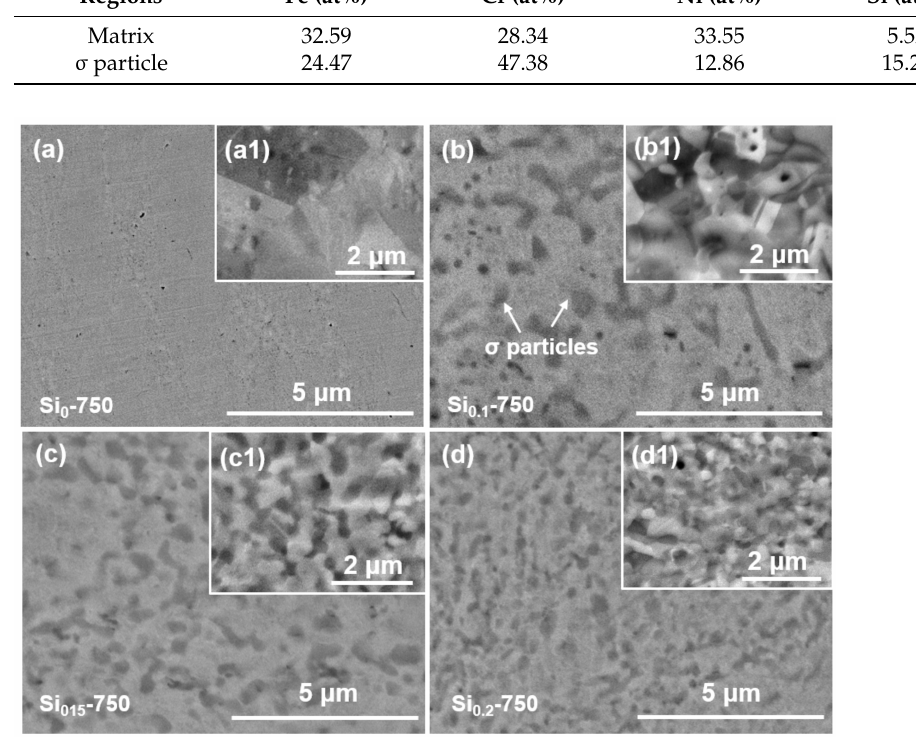
Figure 5. SEM images of the ( a , a1 ) Si 0 -750, ( b , b1 ) Si 0.1 -750, ( c , c1 ) Si 0.15 -750, and ( d , d1 ) Si 0.2 -750 MEAs. The inserted ECCI images show the corresponding microstructure at a high magnification